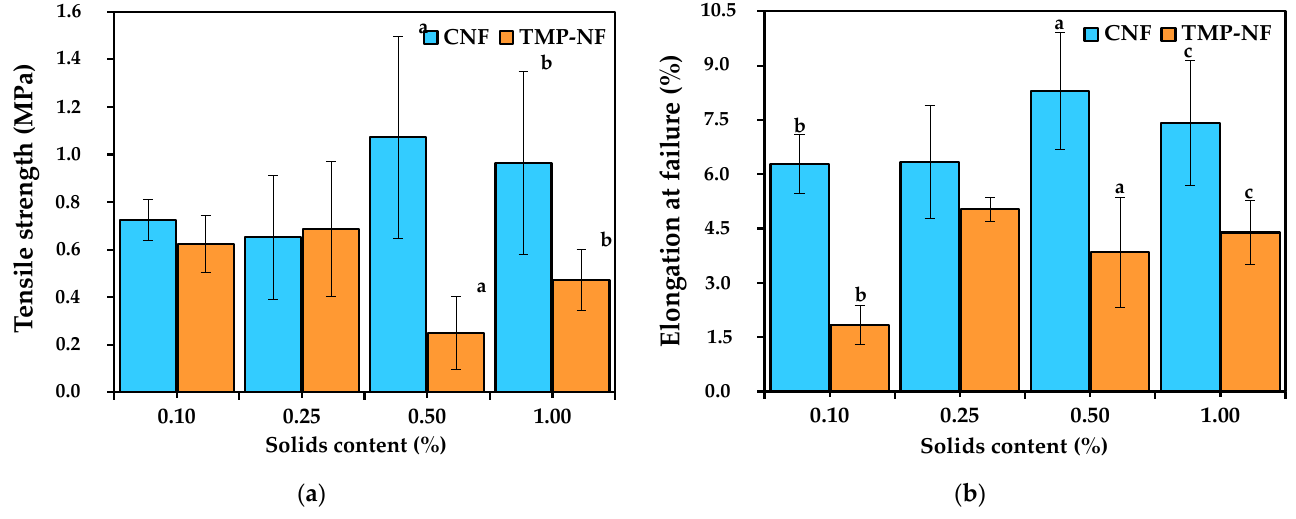
Figure 14. Mechanical analysis of the developed films. ( a ) Tensile strength; ( b ) Elongation at failure. Note: Values are presented as means ± SD. N = 6. Values followed by common letters in the super index indicate estimated significant differences between each pair of means media ( p > 0.05).